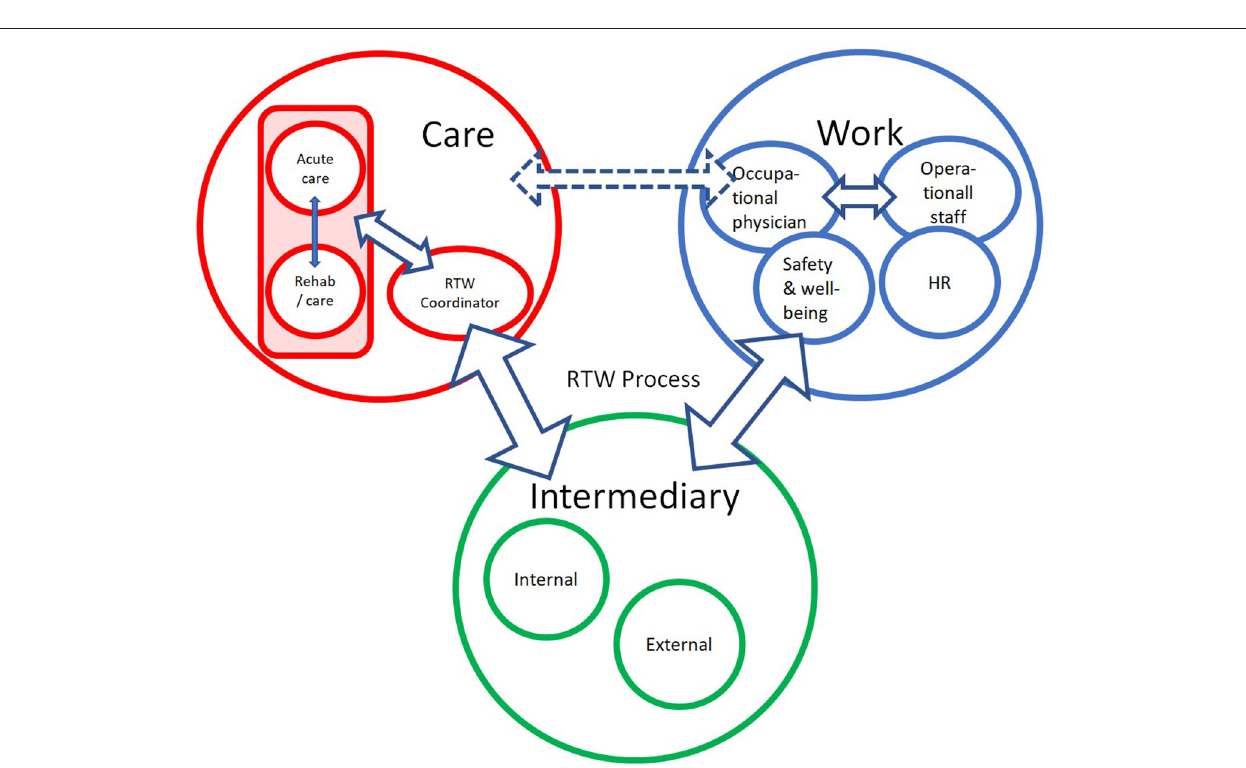
FIGURE 3 | Schematic representation of the overview of the current meaning of the work-oriented approach. HR, Human Resources Department; Red circle indicates who within care is involved in RTW support; Blue circle refers to the stakeholders in the workplace; Green circle refers to specialists who play a role in the RTW process but are not part of the care team of the oncology or revalidation